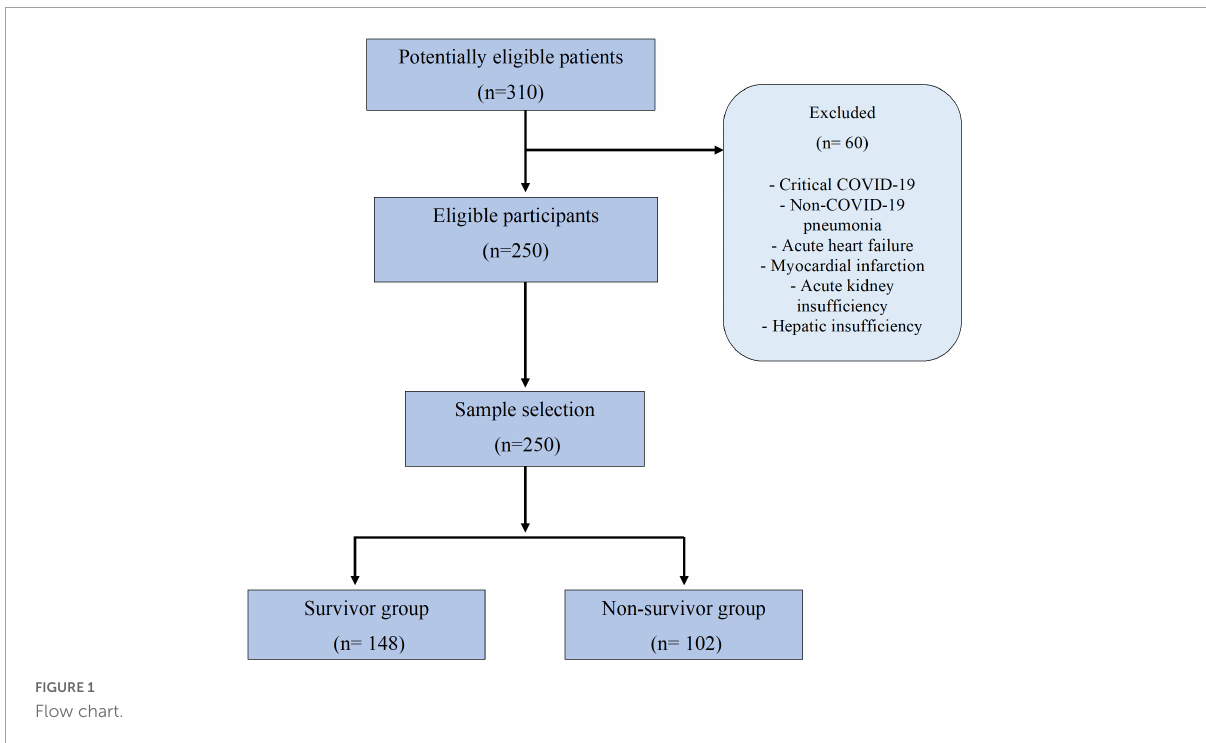
FIGURE1 Flow chart.